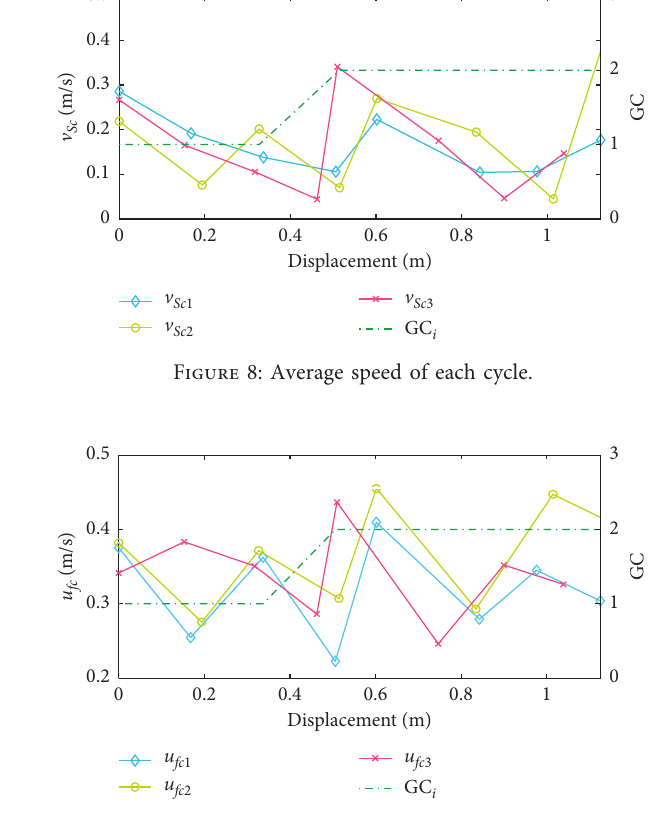
Figure 9: Horizontal velocity of robot’s CoM at the end of each DSP.